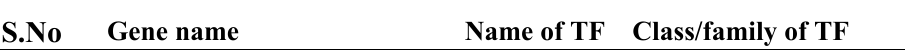
Table 5 : Mouse gene with number of TFs involved for their regulation and class/family name of TFs (Data is extracted from TRRD database)